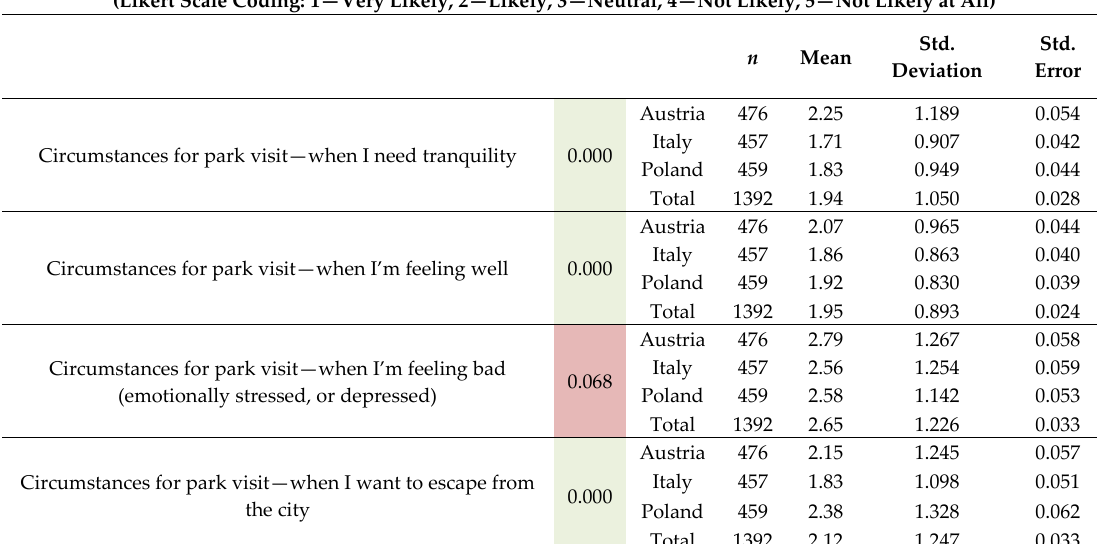
Table 3. Cross-country comparison indicating the likelihood to visit the PA under diverse circumstances (green = highly significant differences, orange = significant differences, red = no significant differences). Under Which Circumstances Do You Visit This Park?